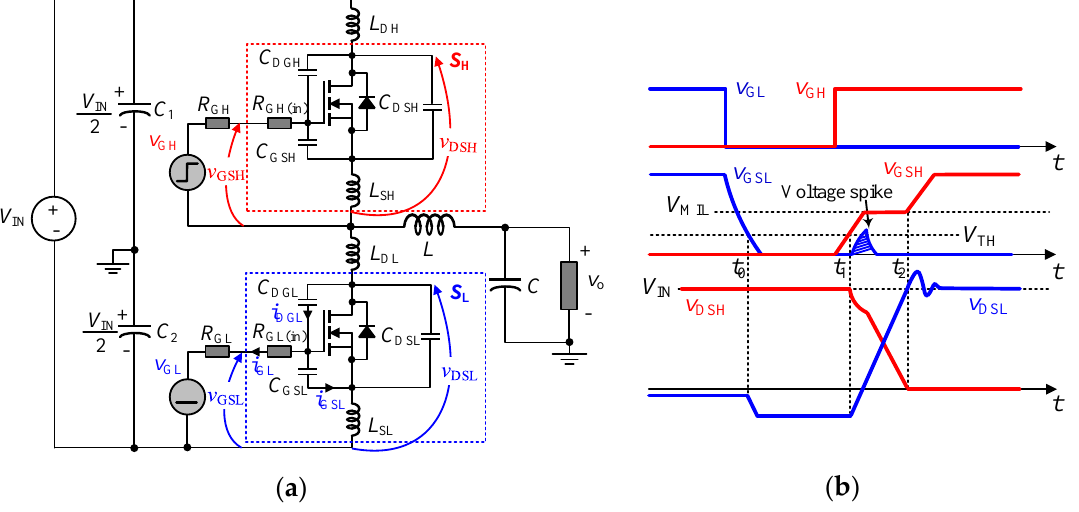
Figure 1. ( a ) Equivalent circuit of the SiC MOSFET based half-bridge dc-ac converter with the parasitic components ( b ) illustration of voltage spike during turn-on transition of high-side MOSFET.